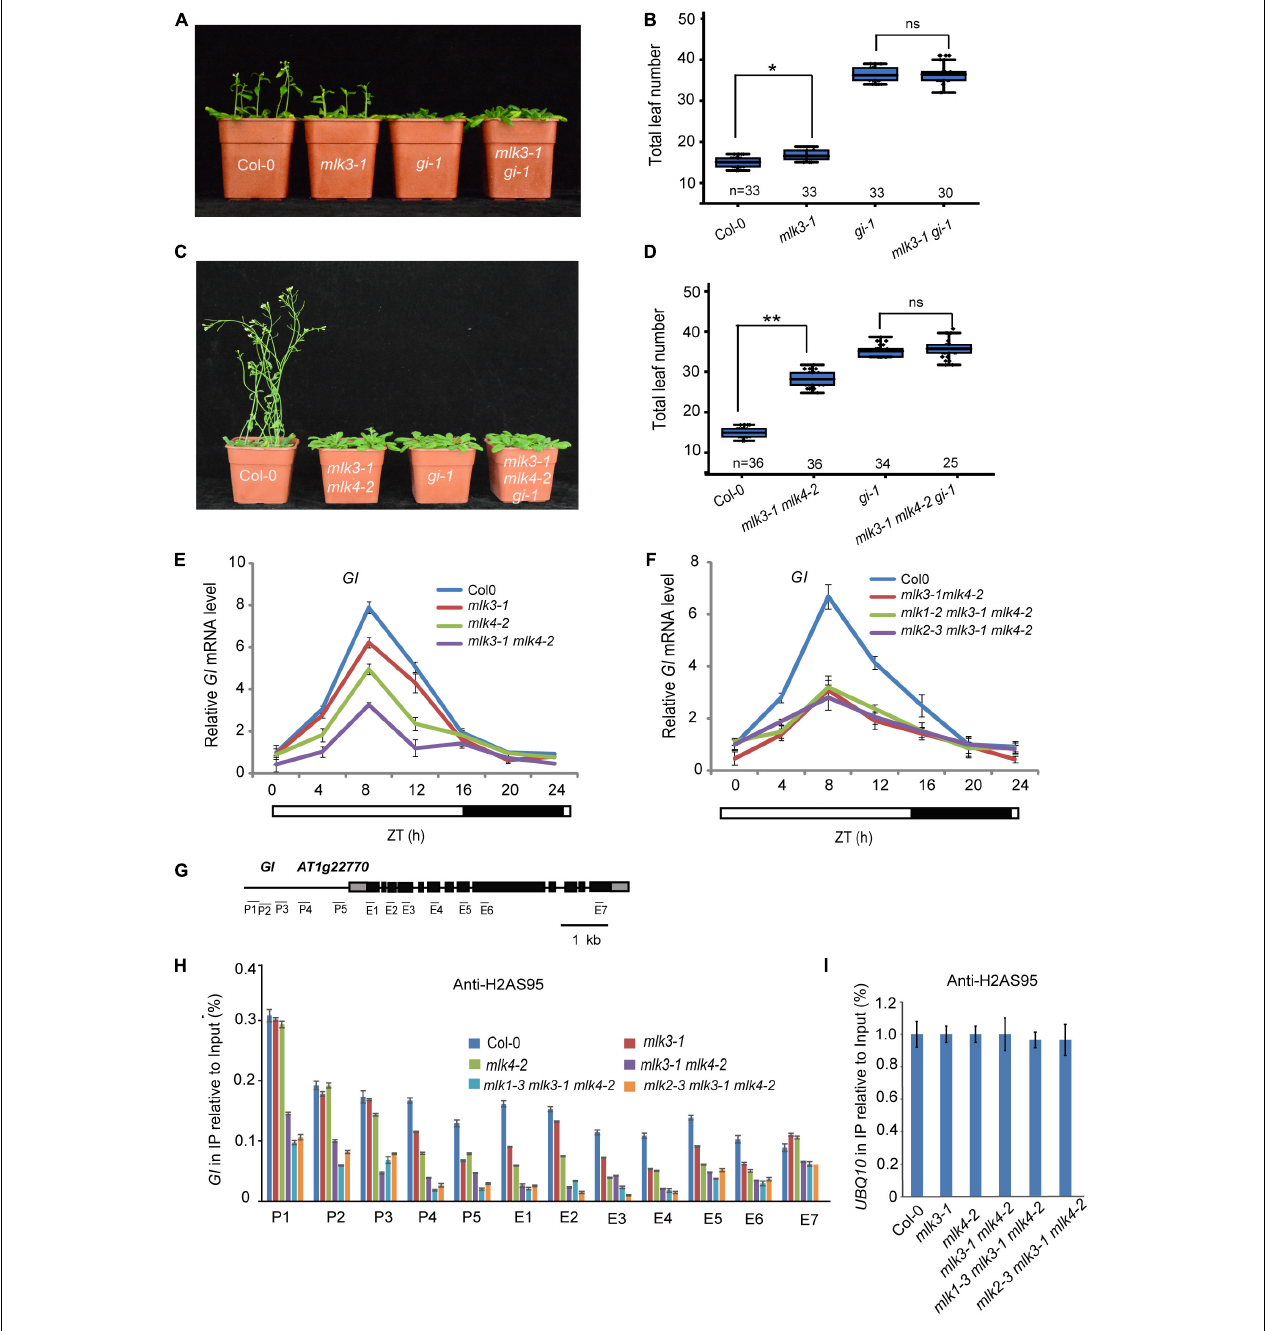
FIGURE 6 | MLK3 and MLK4 are required for H2A phosphorylation at serine 95 at GI . (A) The representative phenotype of Col-0, mlk3-1 , gi-1 , and mlk3-1 gi-1 plants under a LD photoperiod is shown. (B) The total leaf number of Col-0, mlk3-1 , gi-1 , and mlk3-1 gi-1 plants under a LD photoperiod. Values shown are mean ± SD of total leaves; At least 30 plants were scored for each line. Asterisks indicate P < 0.05 and ns indicates no significance by t -test. (C) The representative phenotype of Col-0, mlk3-1mlk4-2 , gi-1 , and mlk3-1mlk4-2 gi-1 plants under a LD photoperiod. (D) The total leaf number of Col-0, mlk3-1mlk4-2 , gi-1 , and mlk3-1mlk4-2 gi-1 plants under a LD photoperiod. Values shown are mean ± SD of total leaves; At least 25 plants were scored for each line. Asterisks indicate P < 0.01 and ns indicates no significance by t -test. (E,F) The transcript levels of GI were examined in mlk3-1 , mlk4-2 and mlk3-1 mlk4-2 mutants (E) , and in mlk3-1 mlk4-2, mlk1-3 mlk3-1 mlk4-2 , and mlk2-3 mlk3-1 mlk4-2 plants (F) . The white bar indicates the light periods, and the black bar indicates the dark period. ZT, Zeitgeber time. Experiments were repeated at least three times, and the representative experiments shown indicate the mean ± SE, n = 3 replicates. (G) Gene structure of GI , indicating exons (boxes), introns (lines). The primers used for ChIP-PCR are marked with lines. (H,I) The amounts of H2AS95ph at different regions of GI were tested in the mlk3-1 , mlk4-2 , mlk3-1 mlk4-2 , mlk1-3 mlk3-1 mlk4-2 , and mlk2-3 mlk3-1 mlk4-2 plants (H) . Ubiquitin 10 was used as internal control (I) . Experiments were repeated at least three times, and the representative experiments shown indicate the mean ± SE, n = 3 replicates.